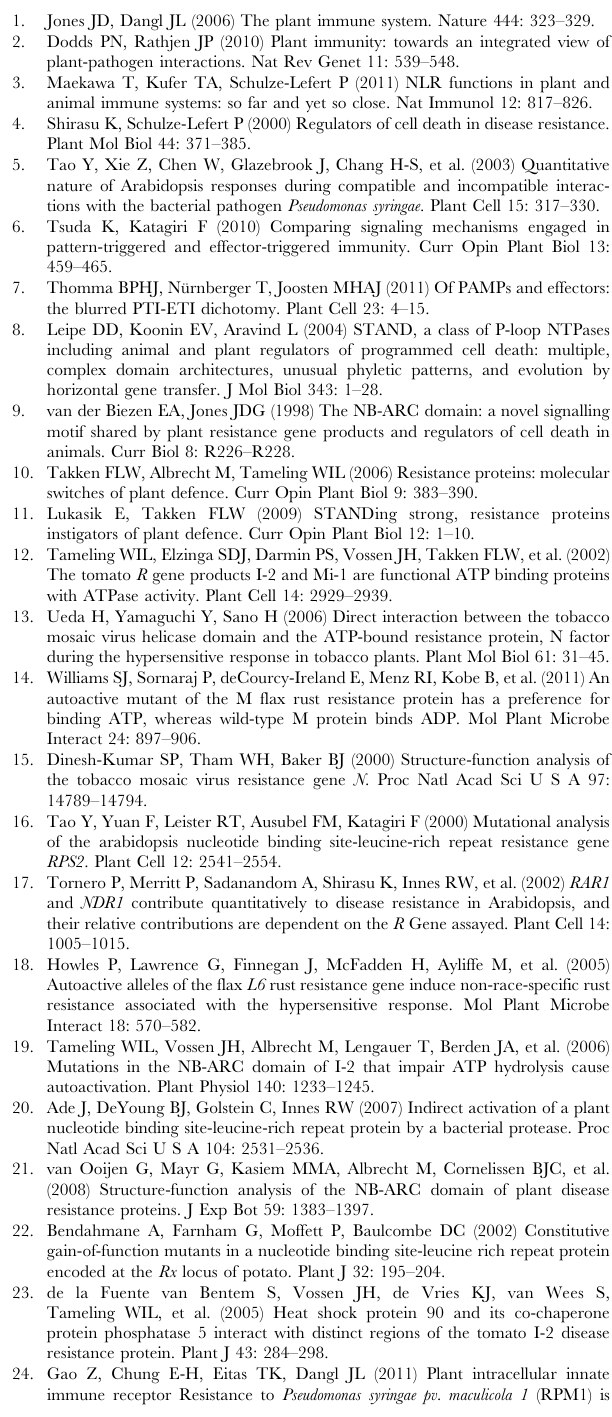
Table S3 Analysis of cell death inducing activity of MLA10 mutant variants in barley cells through transient gene expression